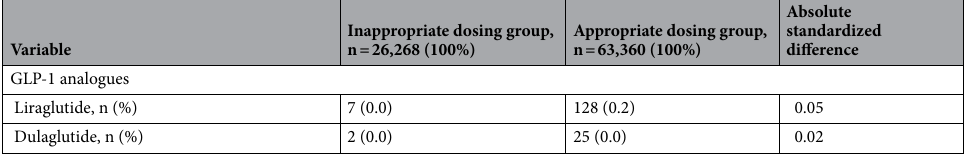
Table 1. Baseline characteristics of patients in the inappropriate dosing and appropriate dosing groups. CCI, Charlson Comorbidity Index; DPP-4 inhibitor, dipeptidyl peptidase-4 inhibitor; SGLT-2 inhibitor, sodium- glucose cotransporter 2 inhibitor.